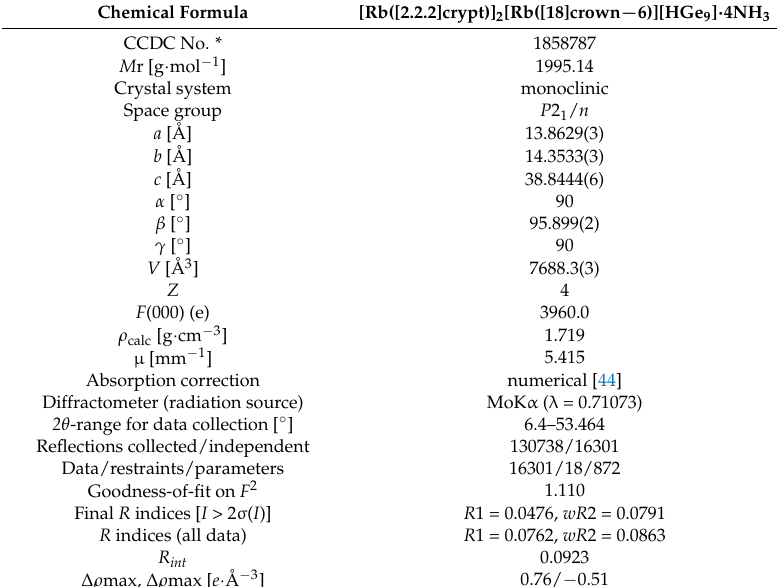
Table 1. Crystallographic data of [Rb([2.2.2]crypt)] 2 [Rb([18]crown − 6)][HGe 9 ] · 4NH 3